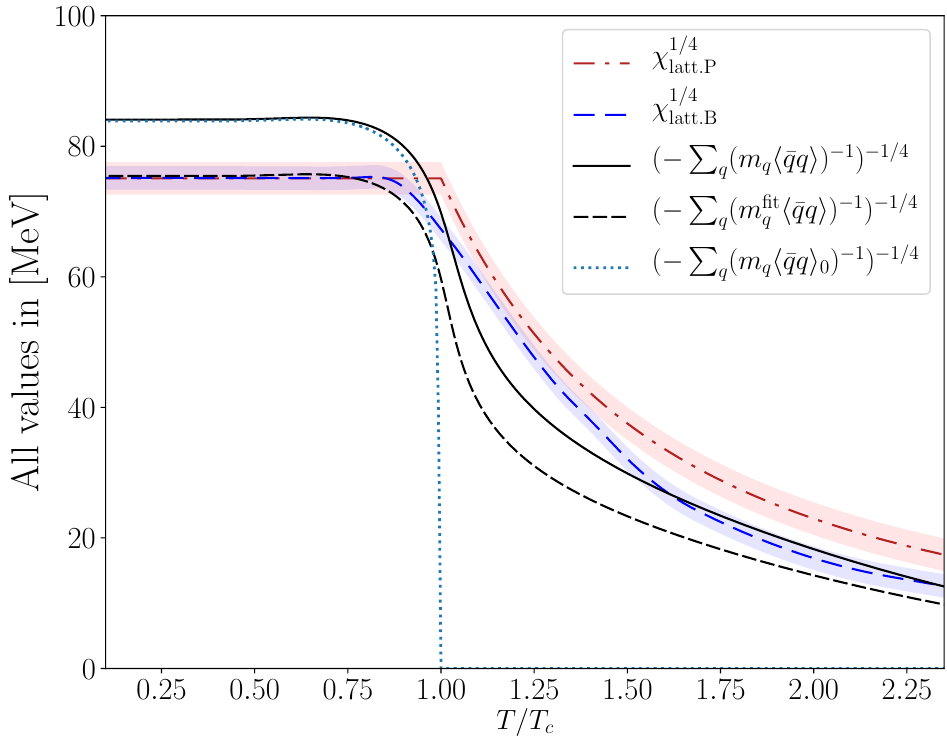
Figure 7. From the calculation in the separable rank-1 DSE model [77], the relative-temperature T / T c dependence of (the leading term of) χ ( T ) 1 / 4 is represented by: (i) the solid curve for the isosymmetric case with m u = m d = 6.6 MeV and m s = 142 MeV, (ii) the dotted curve is for the same mass parameters, but with all condensates approximated by the “massless” condensate ⟨ ¯ qq ⟩ 0 ( T ) , and (iii) the short-dashed curve for the non-isosymmetric case m fit u = 3.15 MeV, m fit m fit s ≡ m s = 142 MeV. The pertinent lattice results are presented in the same way as in the previous two Figures: the dash-dotted and long-dashed curves extracted, respectively, from Refs. [70,71]. Colors